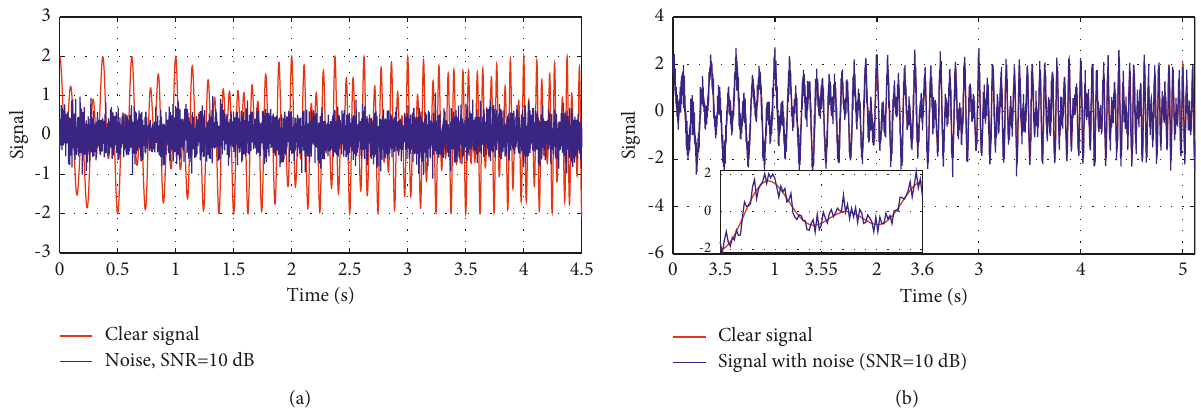
Figure 2: Non-stationary signal: (a) comparison of clear signal and noise; (b) comparison of contaminated and clear